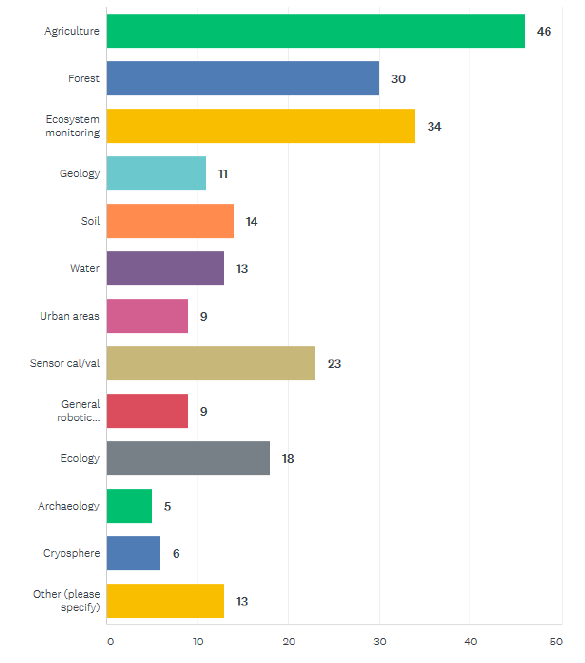
Figure 5 Fields of application of UAV sensing systems (multiple answers possible).